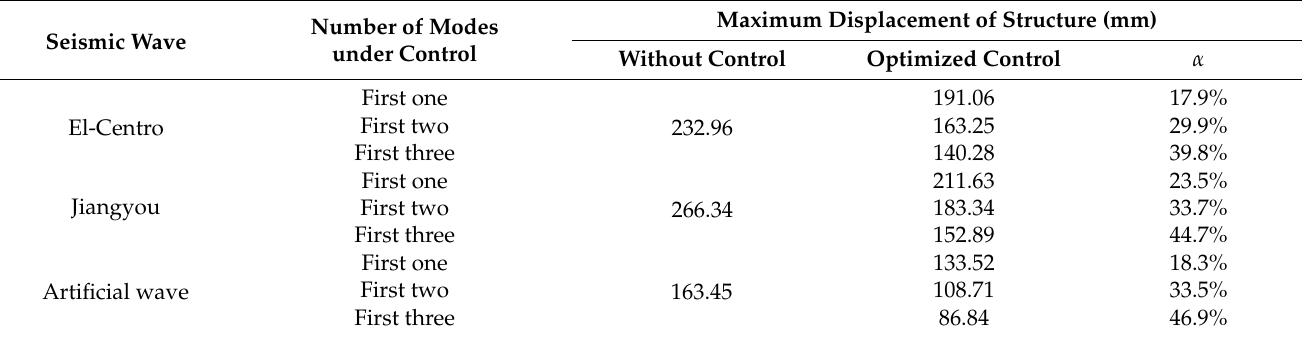
Table 9. Comparison of the optimal control displacement with SMA-SPDS.